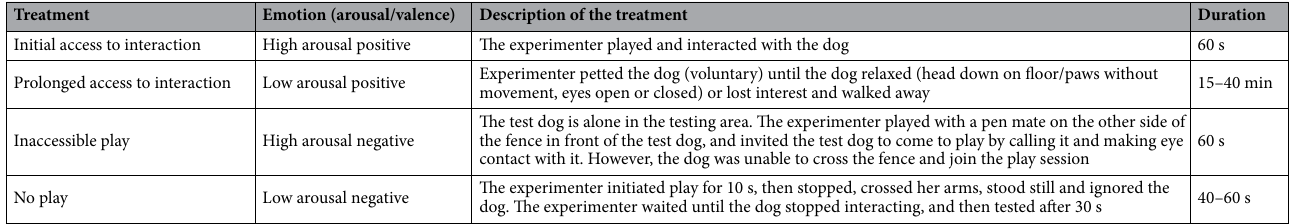
Table 2. Treatments used in experiment 2 that were designed to induce different